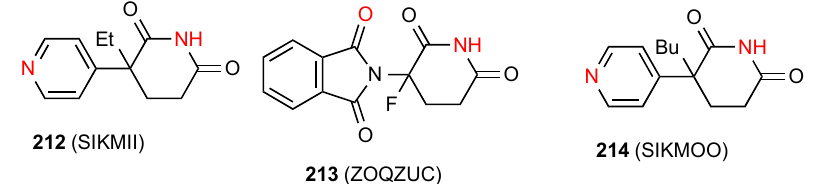
Figure 64. 3,3-Disubstituted glutarimides structures of pattern D or E.